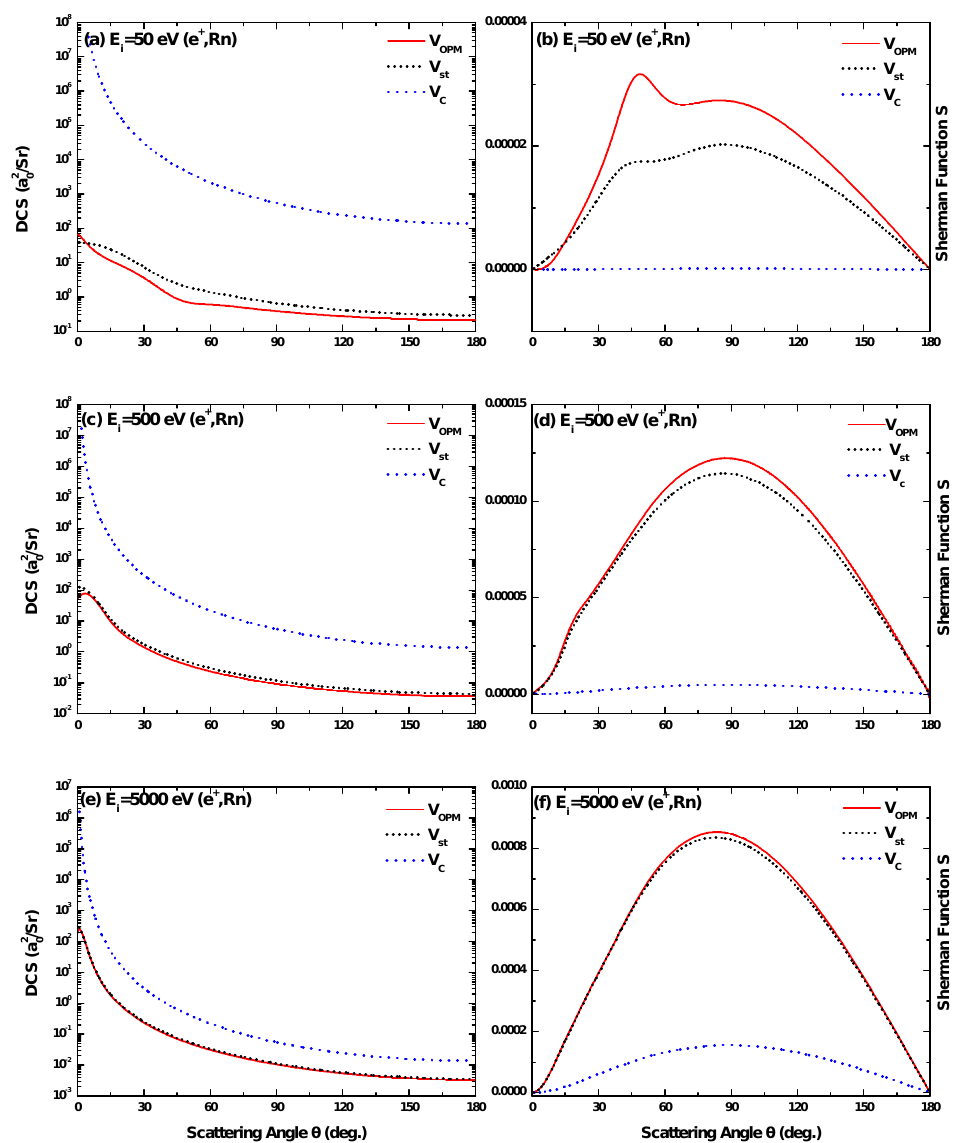
Figure 4. Same as Figure 3, but for the positron impact